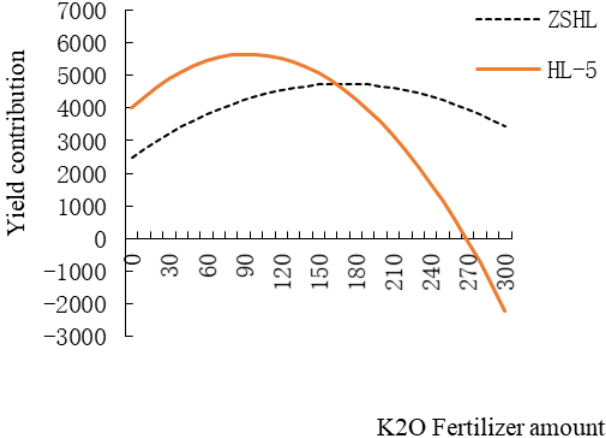
Figure 3. Potassium fertilizer contribution to broccoli yield.